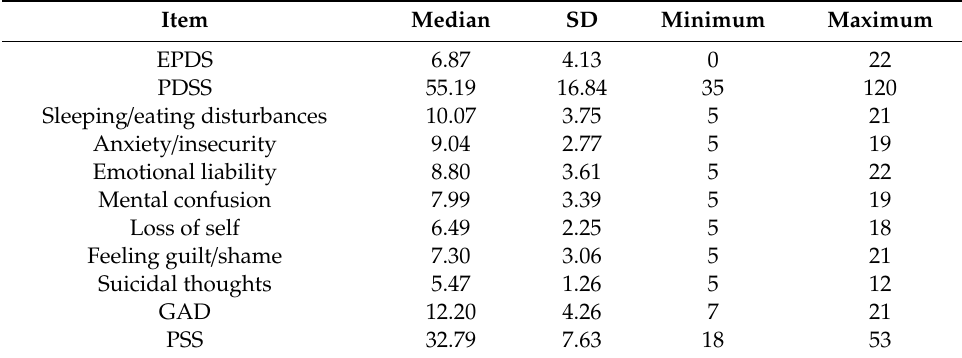
Table 3. Descriptive characteristics of EPDS, PDSS, GAD, PSS ( n = 150).